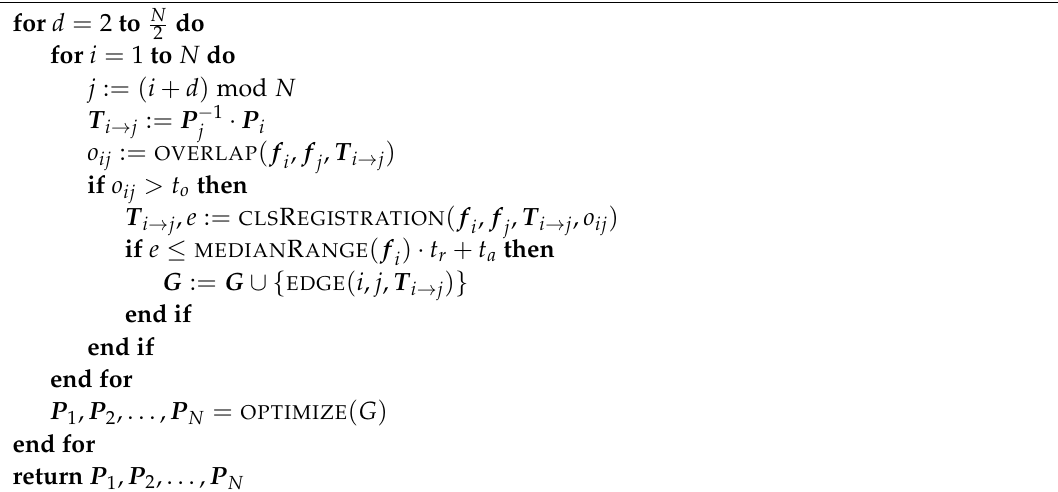
Algorithm 1 Progressive refinement of 6DoF poses { P i } N optimizing pose graph G